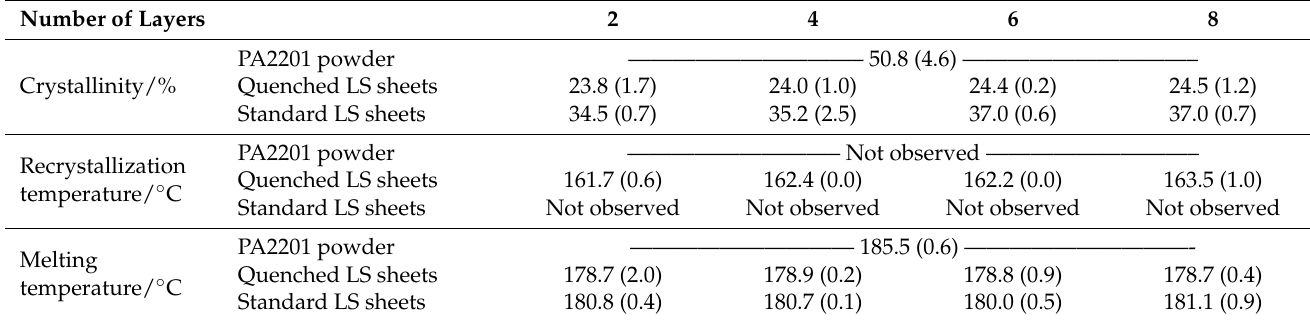
Figure 2. Differential scanning calorimetry curves of the first heating run of PA2201 polyamide 12 powder and ( a ) quenched and ( b ) standard laser-sintered (LS) polyamide 12 sheets generated with two, four, six, and eight layers. Table 1. Thermal properties of PA2201 polyamide 12 powder and quenched and standard laser-sintered (LS) polyamide 12 sheets generated with two, four, six, and eight layers. Values are the average from three individual samples with the standard deviation shown in